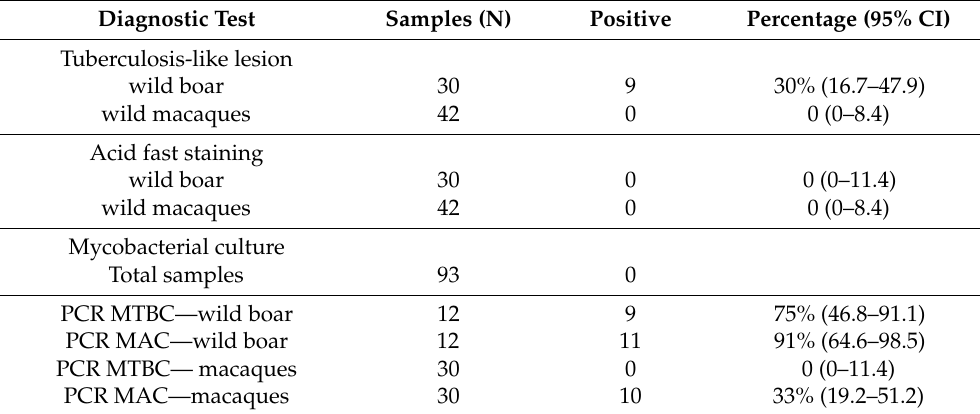
Table 2. Prevalence of the diagnostic test for detection of MTBC and MAC in wild boar and wild macaques.